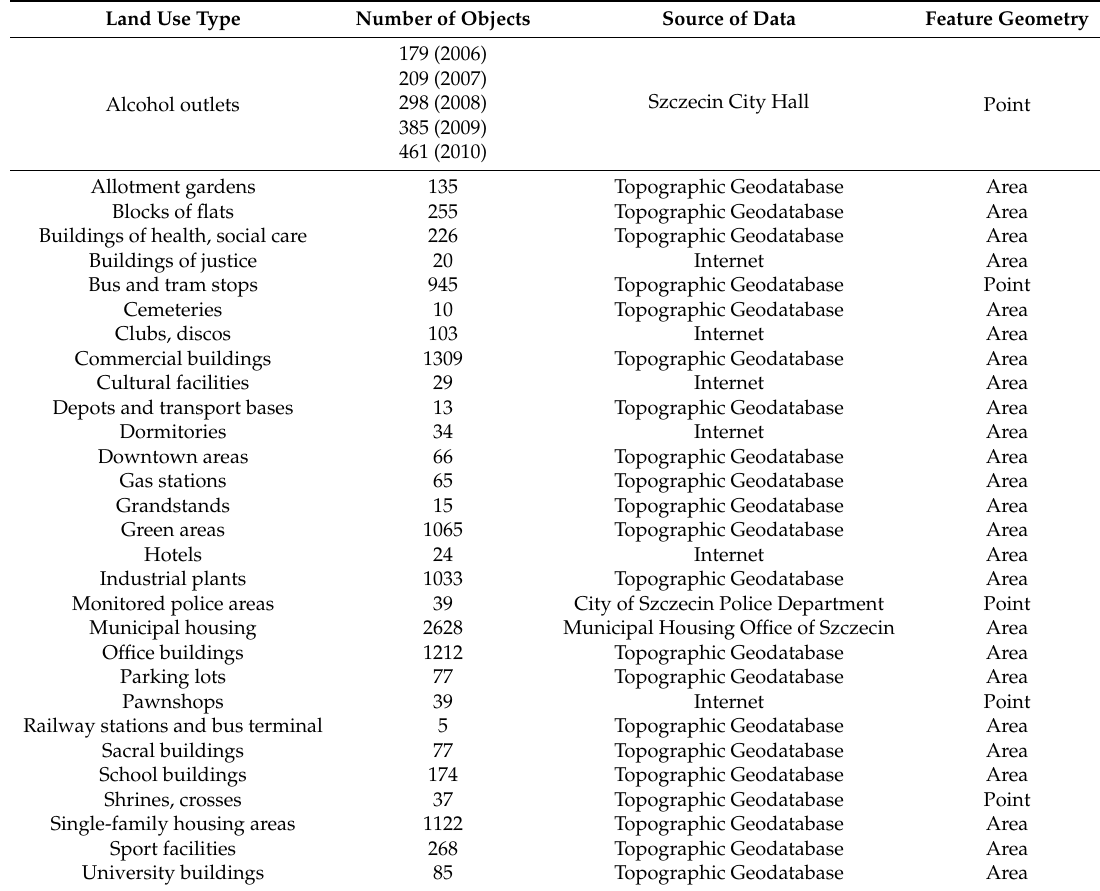
Table 3. Land use types potentially influencing the spatial distribution of